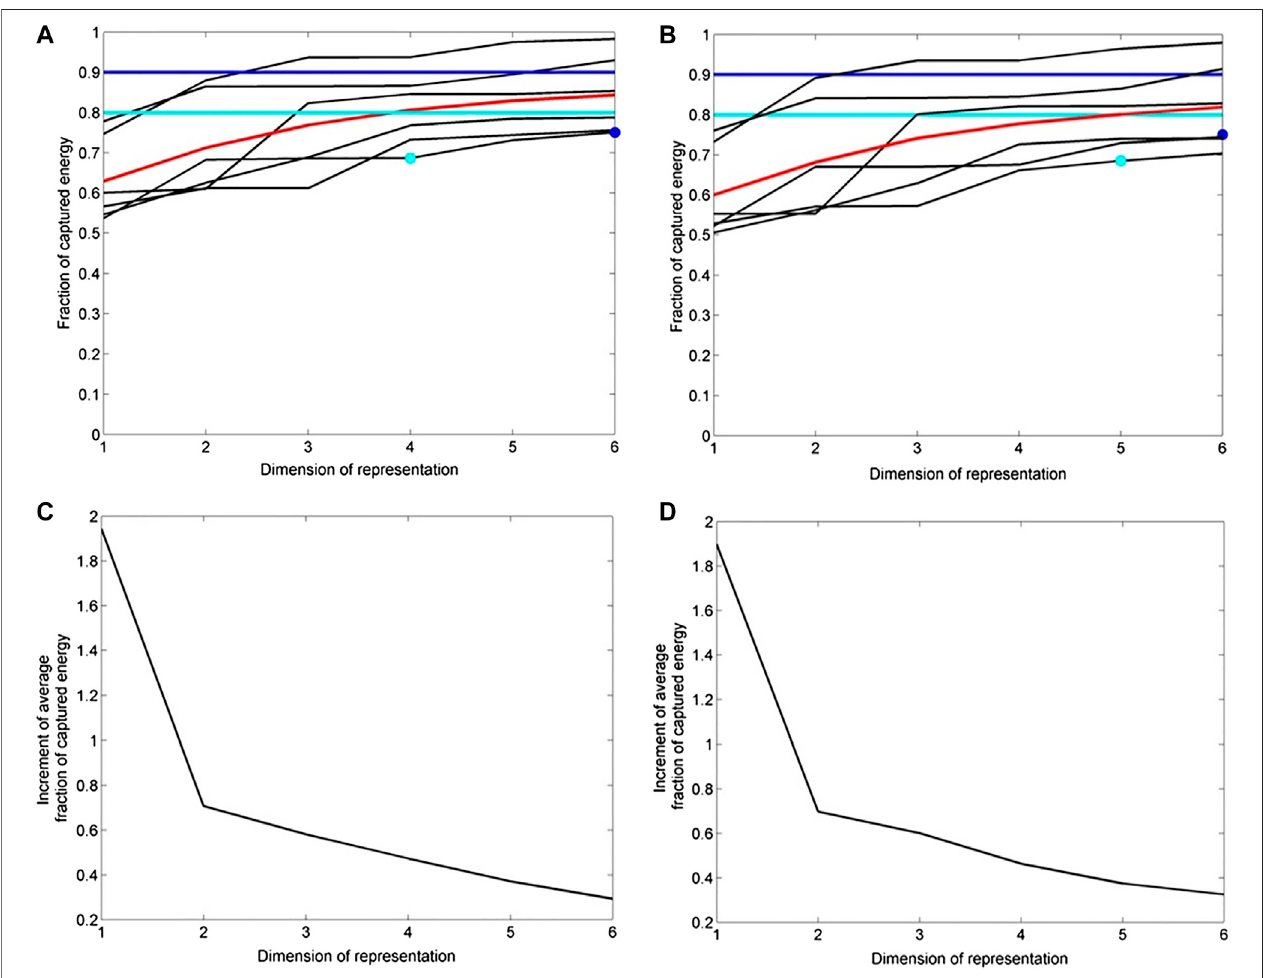
FIGURE 4 | Fraction of captured energy by each template of the designed matrix in function of the subspace dimension for signal fi ltered in the band 1 – 10 Hz (A) and in the band 0.5 – 10 Hz (B) . Black curve represents captured energy by each template, red curve the average captured energy, while, blue and light blue lines representthe90and 80percentage ofcaptured energy,respectively.Incrementofaveragefractionalcaptured energy ( Δ f c ),infunctionofsubspace dimension forsignal fi ltered in the band 1 – 10 Hz (C) and in the band 0.5 – 10 Hz (D) .